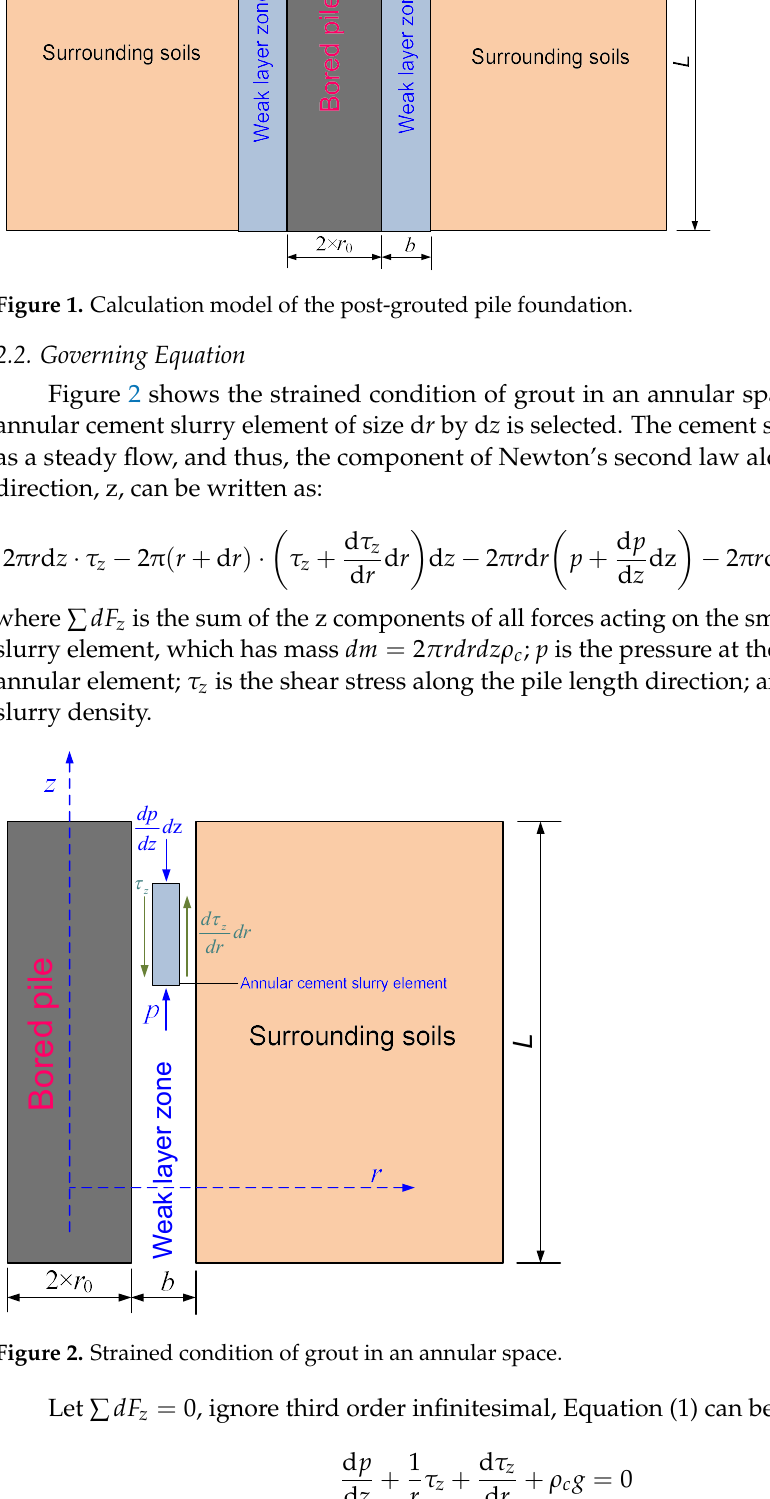
Figure 1. Calculation model of the post-grouted pile foundation.